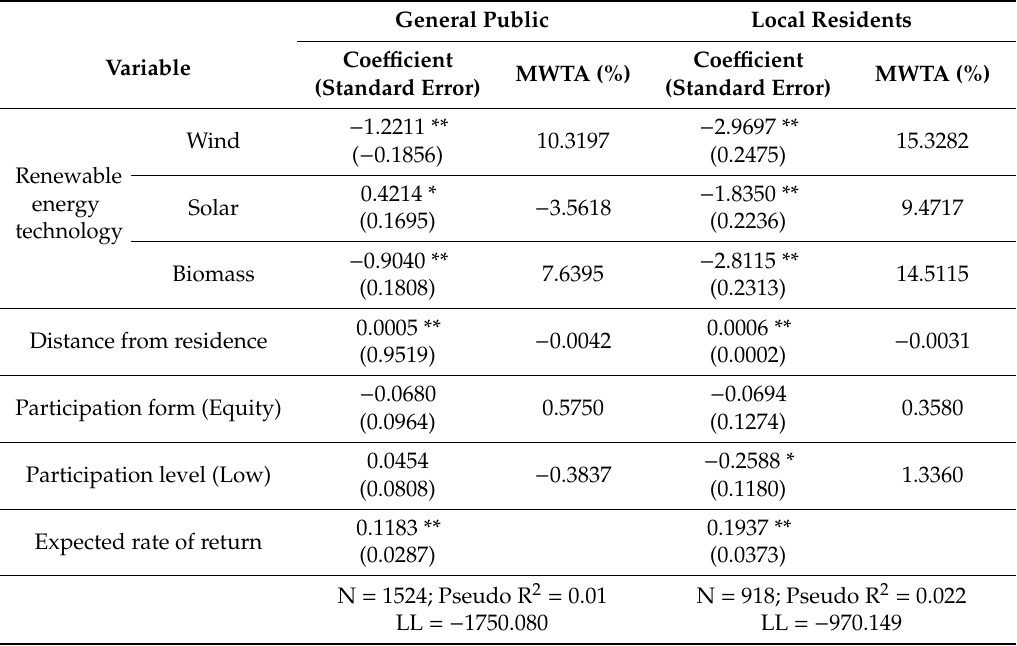
Table 5. Estimation results of multinomial logit